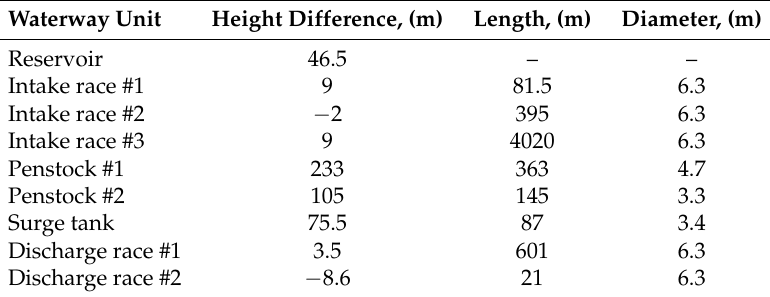
Figure 1. Overview of the structure of the high head hydropower plant. Table 1. The waterway geometry; Trollheim plant.